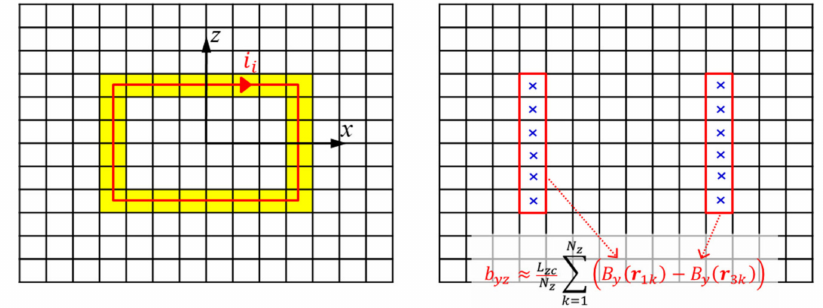
Figure 7. Approximated computation of b yz for the simplified levitation